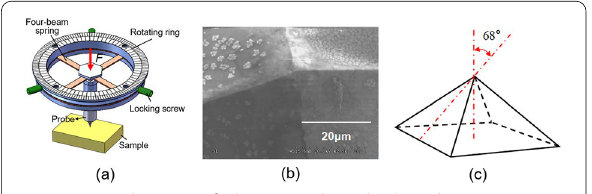
Figure 1 a Schematic of a home-made probe-based force-controlled micromachining system, b SEM image of the Vickers indenter, c geometric schematic of the Vickers